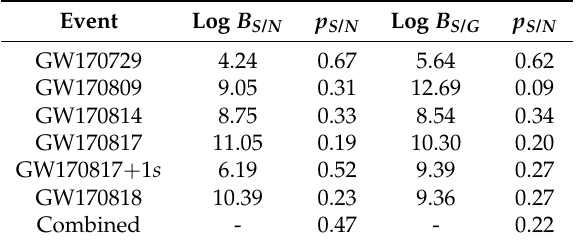
Table 21. Same as Table 20, while for the events that three detectors has been involved [147]. In the case of GW170817, in order to cover 1.0 sec after the merger for echoes found by Abedi and Afshordi [20], additional search as first echo being from this time has been set. For this particular event, latter prior choice has been taken for combined p